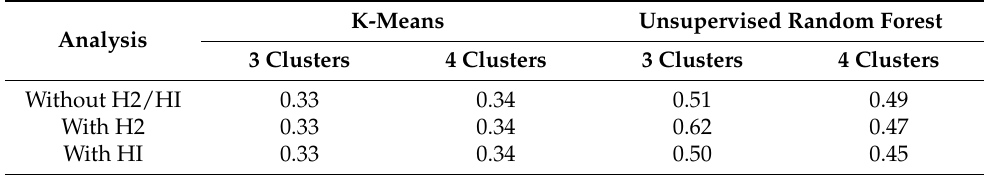
Table 1. Average Silhouette Indexes for 3 and 4 clusters for k-means and optimised URF.